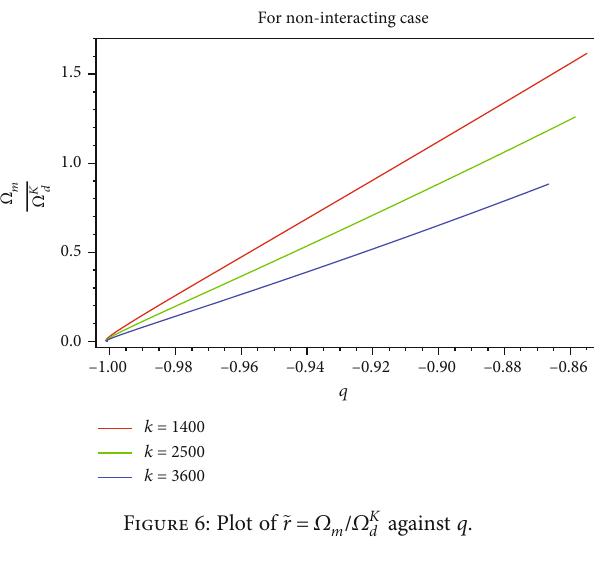
Figure 5: Plot of coincidence parameter ~ r = Ω deceleration parameter q .